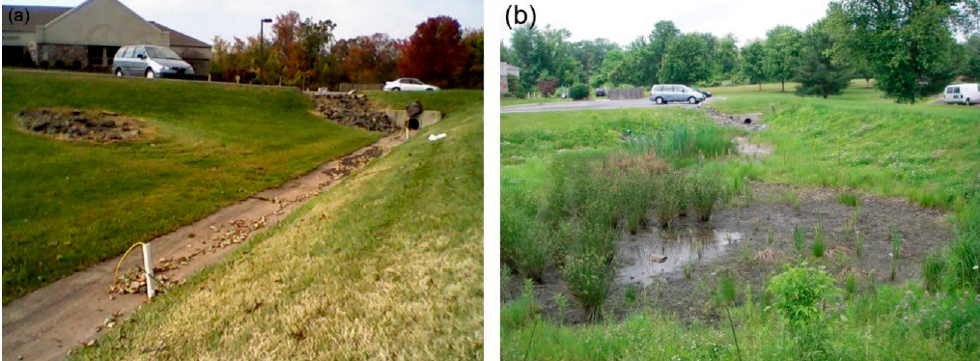
Figure 2. Photograph of a basin ( a ) before and ( b ) after retrofitting.